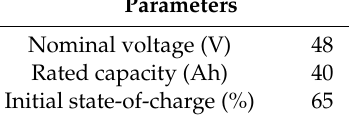
Table 3. Battery Table 3. Battery parameters.